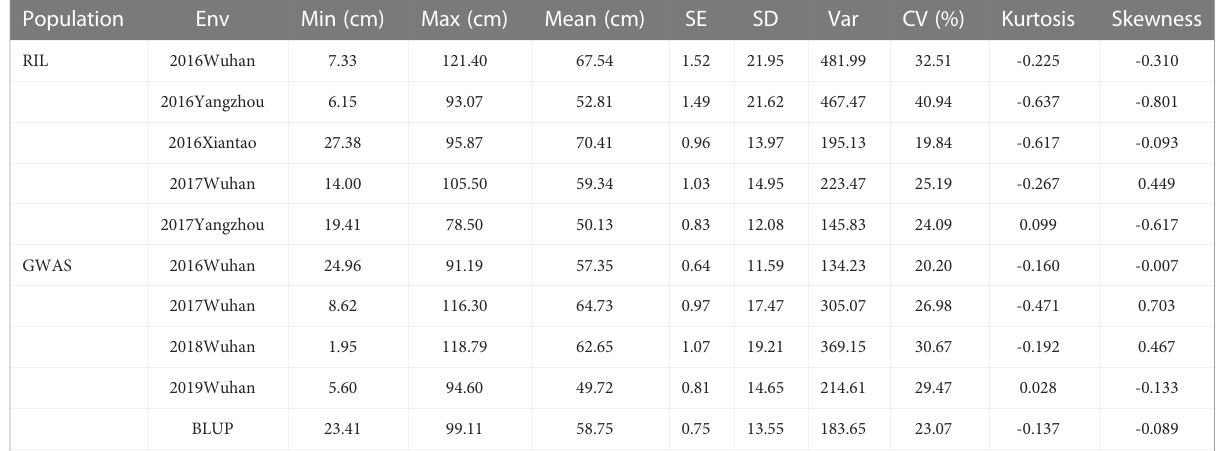
TABLE 1 Phenotypic variation in the linkage and association